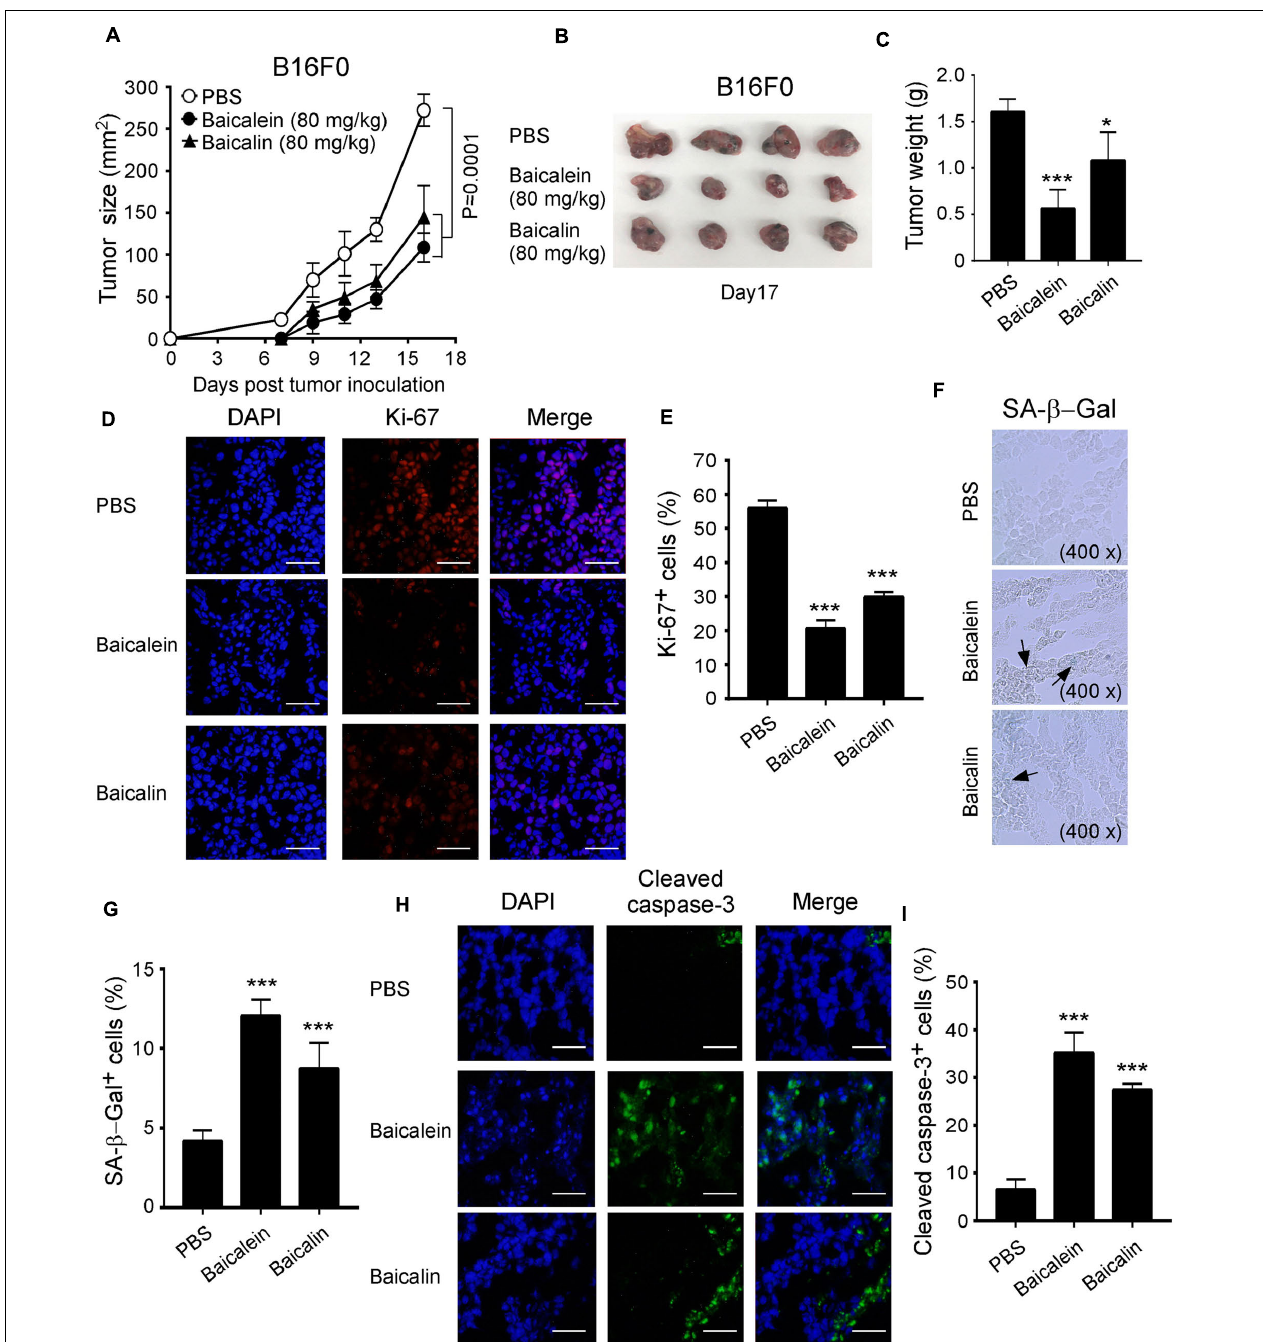
FIGURE 8 | Baicalein and baicalin inhibit tumor growth and tumorigenesis of melanoma in vivo . (A) Both baicalein and baicalin dramatically inhibited B16F0 melanoma tumor growth in NSG immunodeficient mice. B16F0 cells (1 × 10 5 / mouse) were subcutaneously injected into NSG mice. After 4 days post tumor injection (tumor size reached around 5 × 5 mm), the tumor-bearing mice were administrated with baicalein (80 mg/kg), baicalin (80 mg/kg), or PBS control through intraperitoneal injection, respectively at every other day for 2 weeks. Tumor volumes were measured and presented as mean ± SD ( n = 4 mice/group). p values were determined by the one-way analysis of variance (ANOVA). (B) Representative image of B16F0 tumors obtained from the indicated groups at the endpoint of the experiments (day 17). (C) Treatments with both baicalein and baicalin had much lower tumor weights compared with that of PBS control group. Results shown are mean ± SD of the tumor weights from the indicated groups in the B16F0 model at the endpoint of the experiments (day 17) ( n = 4 mice/group). * p < 0.05 and *** p < 0.001, compared with the PBS injection group using unpaired t -test. (D,E) Treatments with baicalein and baicalin significantly decreased the Ki-67 + cell populations in tumor tissues at the endpoint of experiment using an immunofluorescence assay. Panel (D) are representative images of Ki-67 expression in tumor